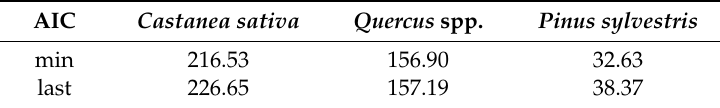
Table 1. AIC values of the Weibull models using the minimum recorded (min) and the last measured (last) stem water potential Ψ STEM .